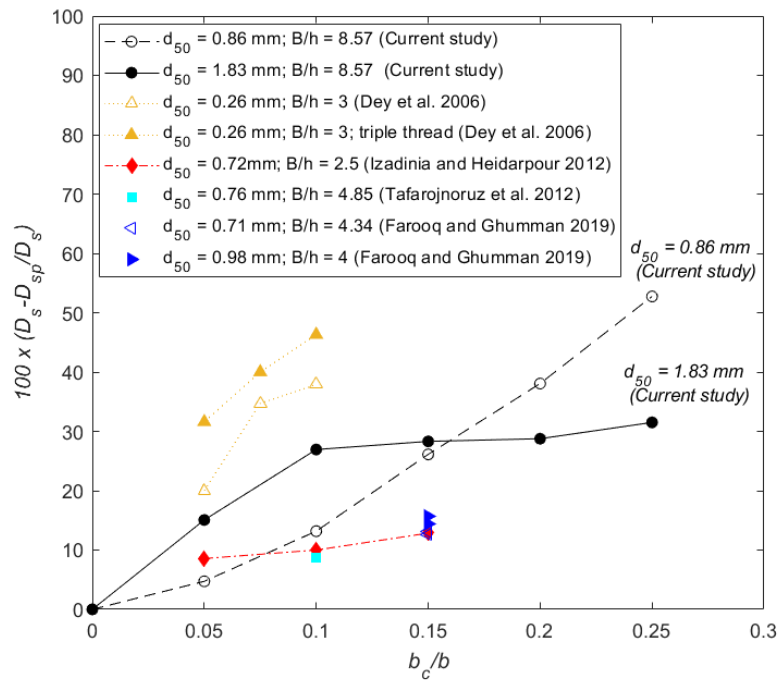
Figure 6. Variation in percentage scour depth reduction of the protected pier compared to the unprotected pier for different cable diameter to pier diameter ratios ( b c /b ) and for different median sediment diameters ( d 50 ). Data from the current study are compared with previous studies. The channel width to flow depth ratio ( B/h ) is given in the legend [10–13].